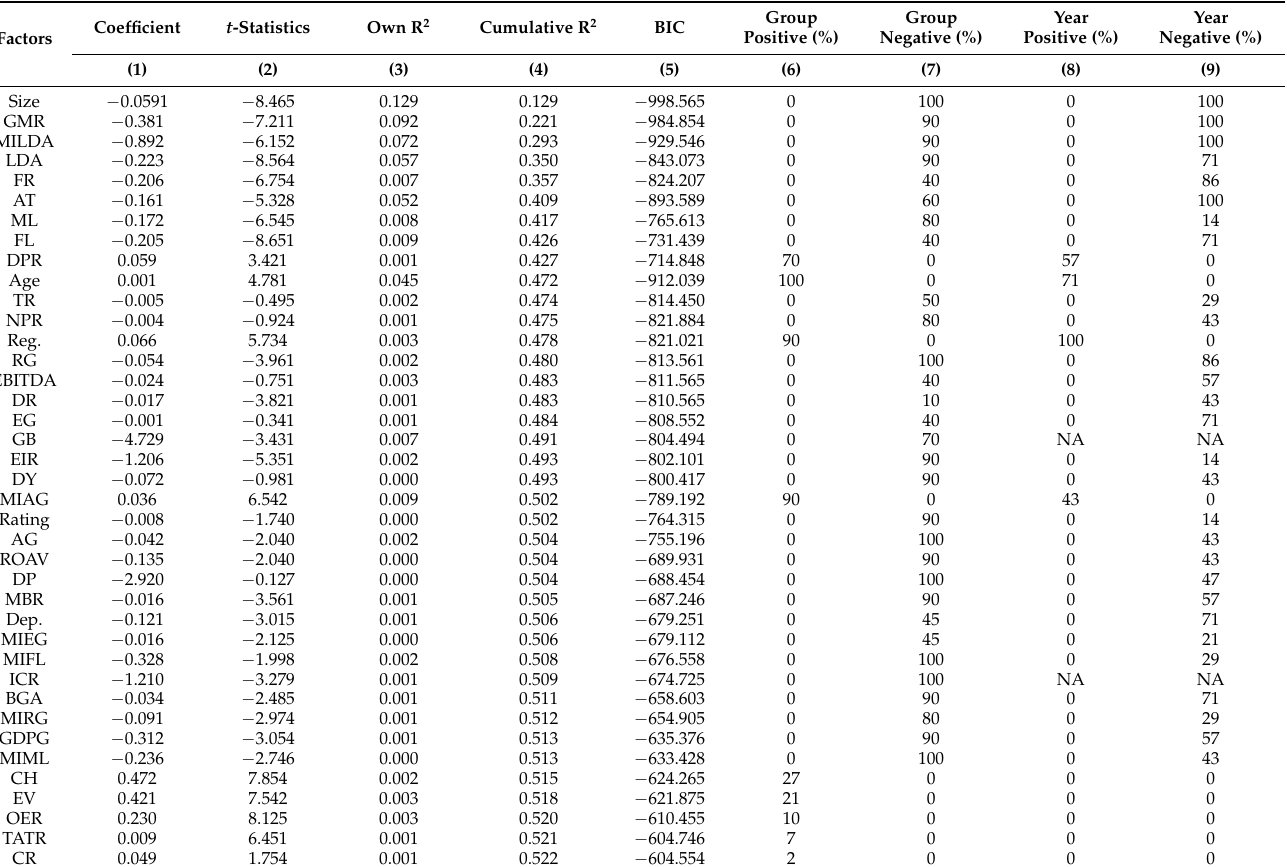
Table 7. Core factor selection using HHI as the dependent